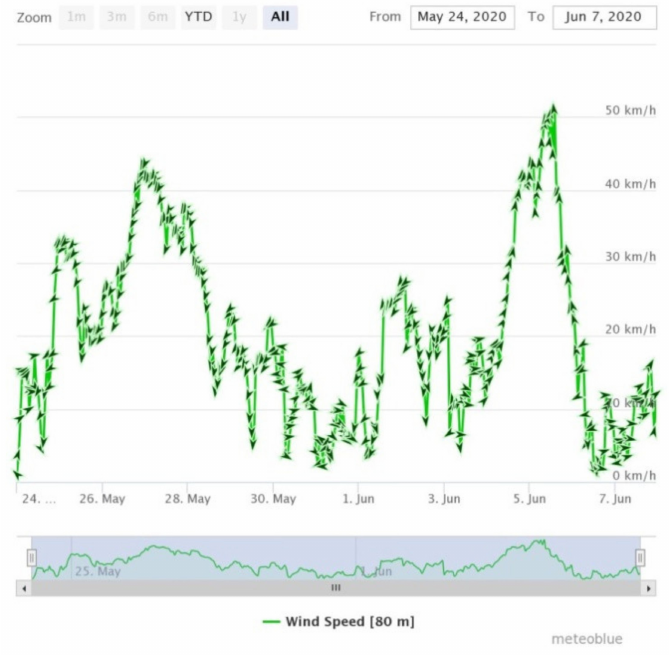
Figure 4. Wind speed graph for the chosen time